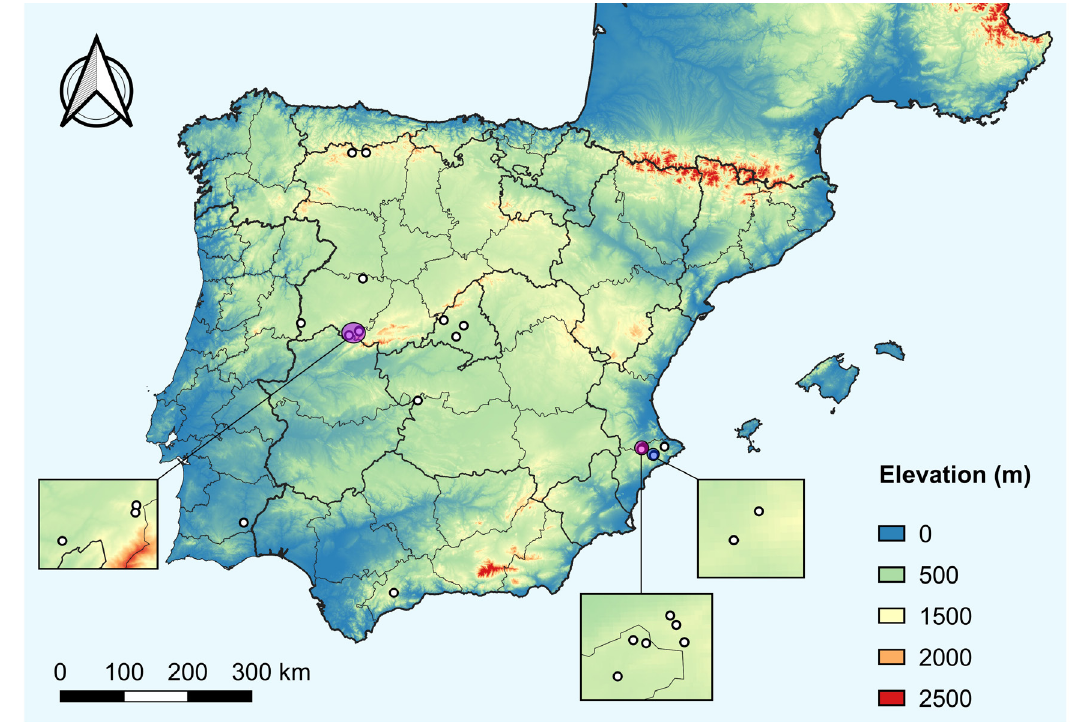
Fig. 1. Distribution map of E. colladoi sp. nov. in the Iberian